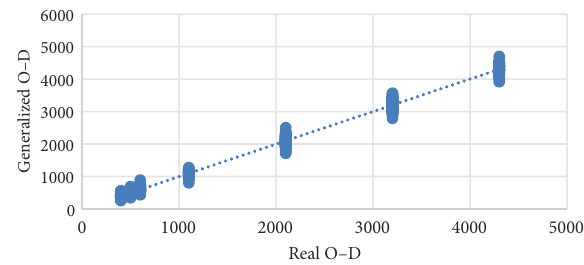
methodologyFigure 5. Generalized O–D matrix versus real O–D matrix for the Nguyen–Dupuis